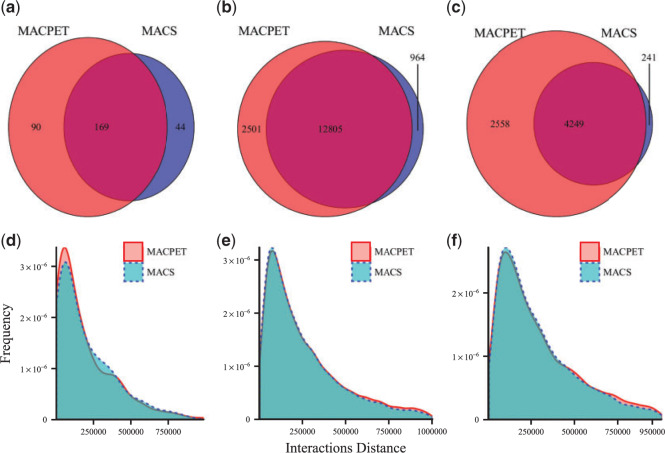
Comparison for MANGO interactions of \documentclass[12pt]{minimal}
\usepackage{amsmath}
\usepackage{wasysym}
\usepackage{amsfonts}
\usepackage{amssymb}
\usepackage{amsbsy}
\usepackage{upgreek}
\usepackage{mathrsfs}
\setlength{\oddsidemargin}{-69pt}
\begin{document}
}{}$500$\end{document} bp window extension. (a–c) Venn diagrams from significant interactions for a \documentclass[12pt]{minimal}
\usepackage{amsmath}
\usepackage{wasysym}
\usepackage{amsfonts}
\usepackage{amssymb}
\usepackage{amsbsy}
\usepackage{upgreek}
\usepackage{mathrsfs}
\setlength{\oddsidemargin}{-69pt}
\begin{document}
}{}$500$\end{document} bp extension window for the significant PBSs from MACPET and MACS for (a) ESR1 (MCF-7), (b) CTCF (MCF-7), (c) CTCF (K562). (d–f) Density plots for the distances of the significant intra-chromosomal interactions from MACPET and MACS for (d) ESR1 (MCF-7), (e) CTCF (MCF-7), (f) CTCF (K562). The x-axis is the sizes of the intra-chromosomal interactions and the y-axis is their density.